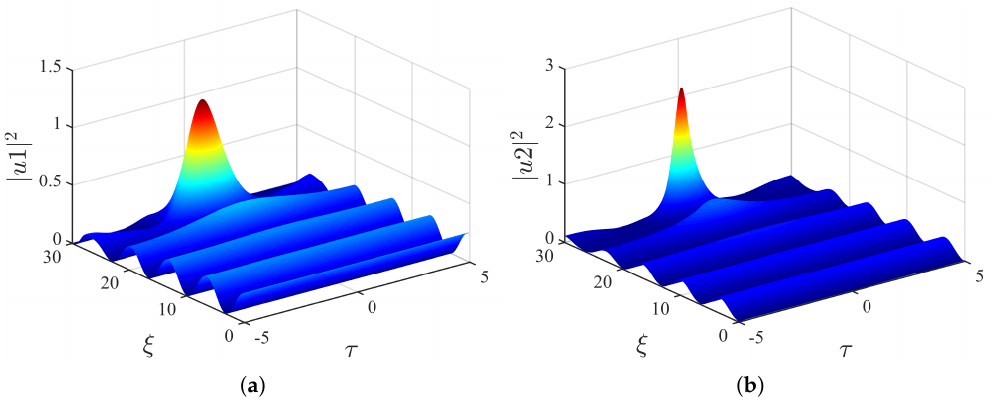
Figure 21. The same as in Figure 20, but for A 1 = 0.5, A 2 = 0.1, a 0 = 0.0007, χ = 0.01 and κ =